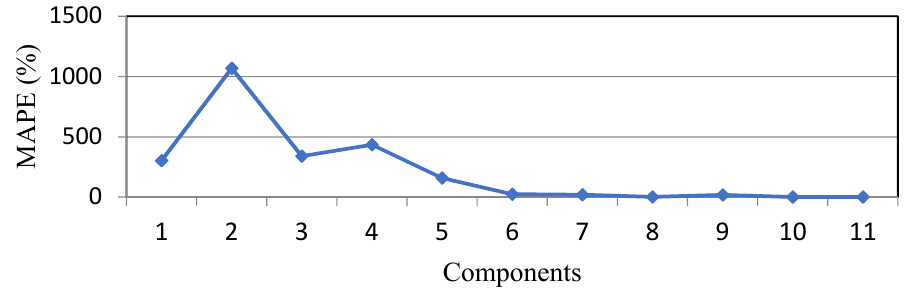
Figure 11. RMSE of prediction for each level using DKF.